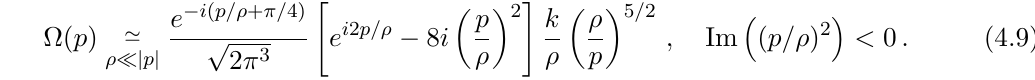
Figure 11 . Contour plot in the plane ( M/ρ, Γ /M ) of log absolute value of the IR-to-IR Green’s function log stand for the positions of the poles of the Green’s function with Dirichlet boundary condition as predicted by eq. (4.9), and given by the analytical formula of eq. (3.46). We have considered A 1 = 35